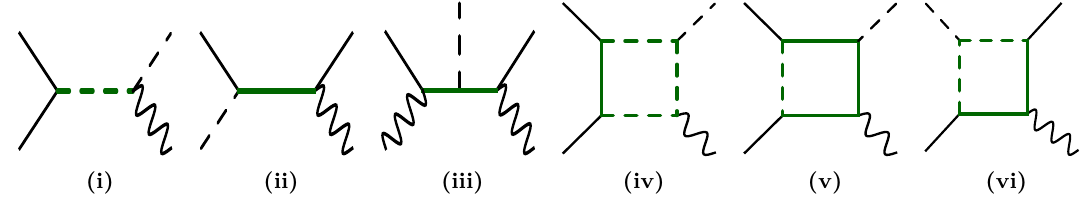
Figure 10 . Tree- (i)–(iv) and one-loop-level (v)–(ix) diagrams built of Lorentz invariant renormal- izable interactions of the UV theory that lead to effective operators of ψ 2 φX